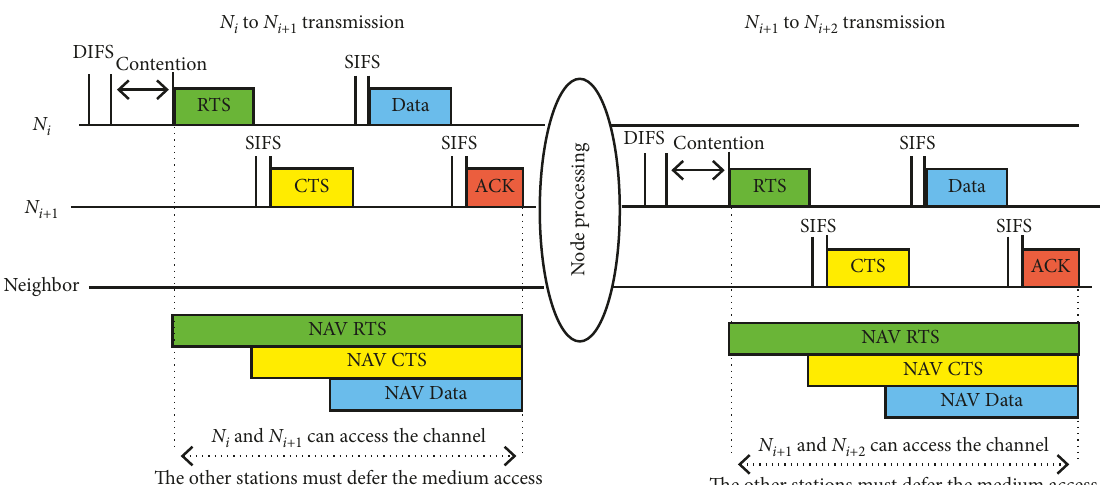
Figure 3: Forwarding process in contention-based